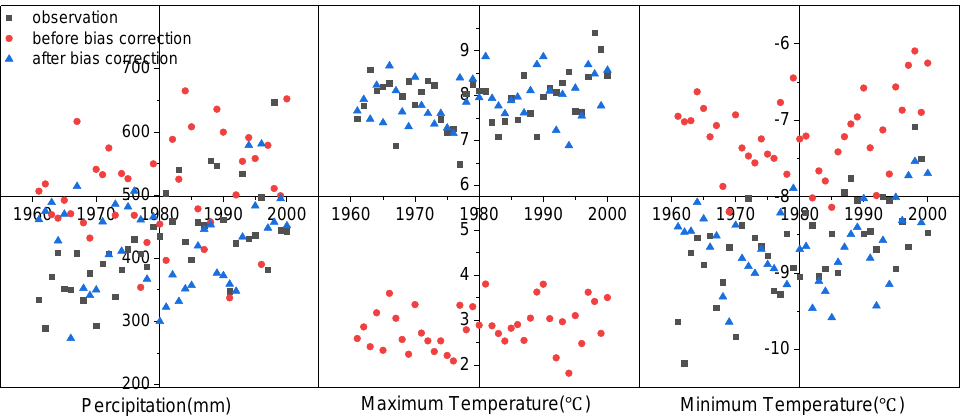
Figure 2. Meteorological data before and after bias correction and historical observations.